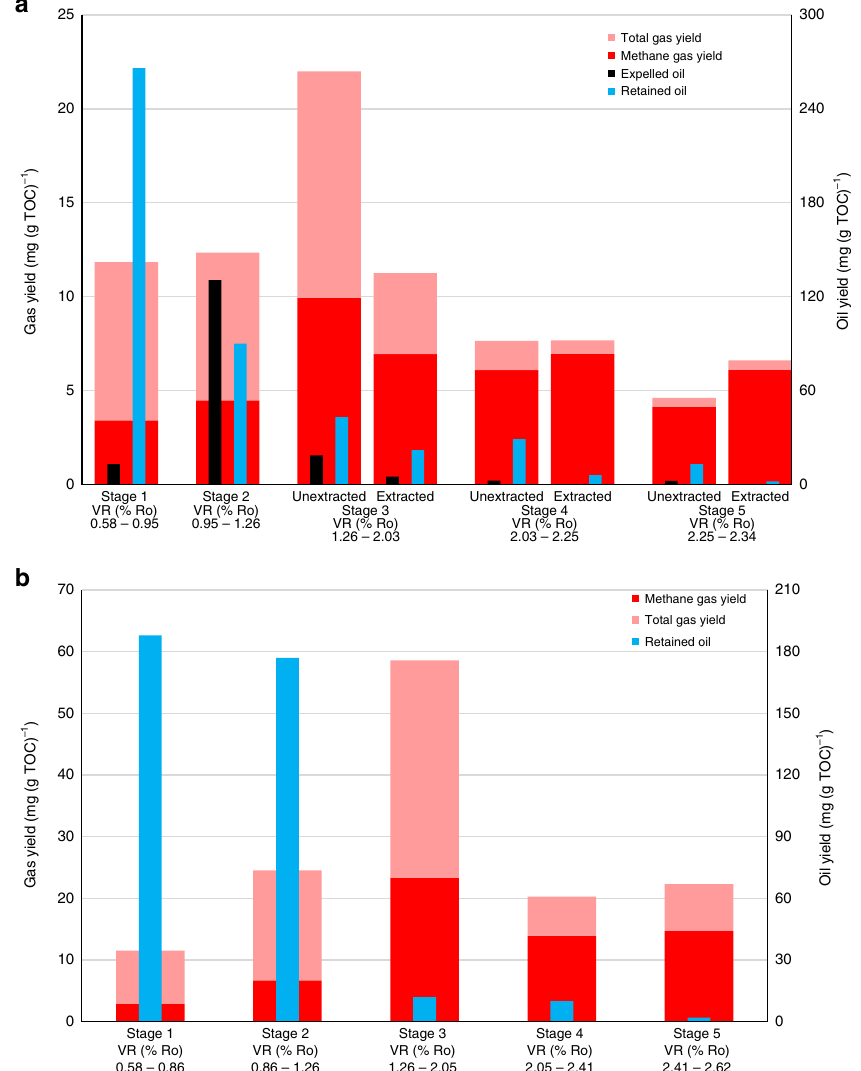
Fig. 1 Total hydrocarbon gas (C 1 – C 5 ), methane, expelled oil and retained oil/bitumen yields (mg/g TOC of the rock at the end of each stage) for the Rempstone shale. a Sequential HPWP (800 bar). b Anhydrous experiments. For stages 3 – 5 in the HPWP experiment, the results are also presented for the sample that was solvent extracted at the end of stage 2. The VR % (Ro) values below each histogram are for the start and end of each stage. The differences in the measured values from duplicate tests are generally within 6% for gas (C 1 – C 5 hydrocarbons) yields, 4% for expelled and retained oil